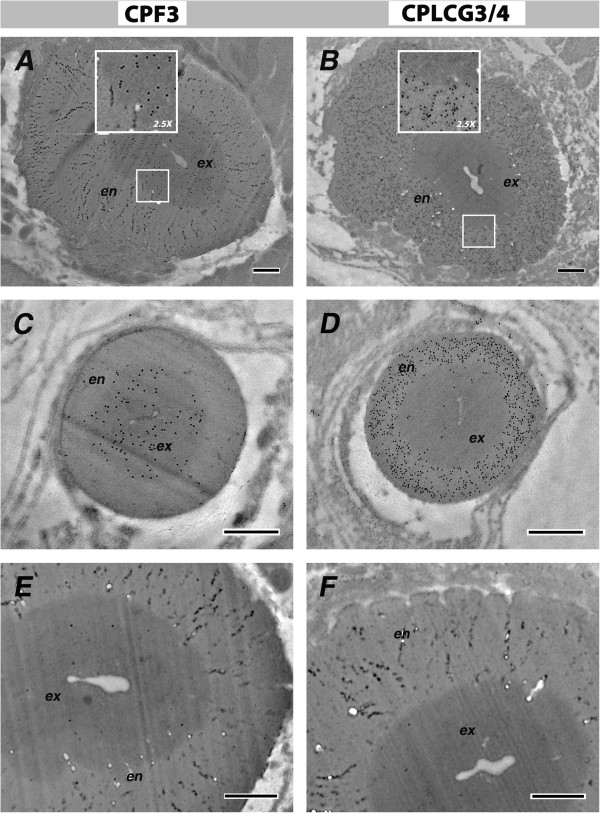
Ultrastructural immunolocalization in leg apodemes of 1-d-old mosquitoes. CPF3 (left panels) and CPLCG3/4 (right panels) are shown in the flexor tibiae apodeme cuticle (A, B); and extensor tibiae apodeme (C, D). (E, F) Control sections treated with the appropriate pre-immune serum; note the granulated structures in the endocuticle. Sections were incubated with goat anti-mouse (A, C, E) or with goat anti-rabbit (B, D, F) secondary antibodies conjugated to 10- and 5-nm gold particles, respectively. ex, exocuticle; en, endocuticle Scale bar=500 nm.